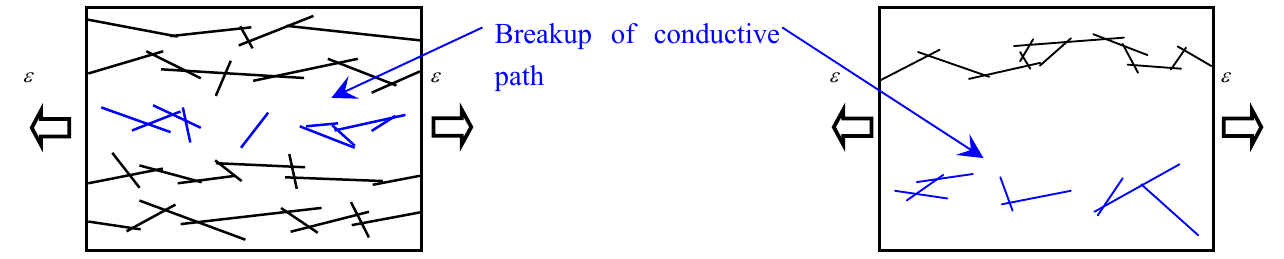
Figure 11. Comparison of intensive and sparse conductive networks under straining.